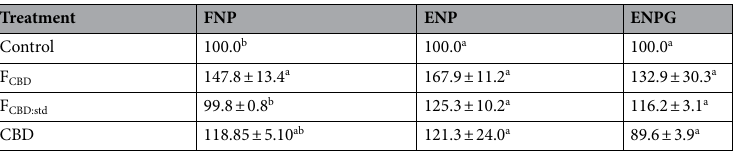
Table 3. Percentage of macrophage cells out of the control with internalized FNP silica beads, presence of ENP and ENPG silica beads analyzed using imaging flow cytometry, following treatment with F CBD at 7 µg/ mL, F CBD:std at 7 µg/mL, CBD at 4.35 µg/mL, or the control. Control (0.7% v/v methanol) treatment served as the solvent (vehicle) control. Fluorescein labeled silica particles (FNP: 50–100 nm, ENP: 30–70 nm, ENPG: 30-70 nm coated with IgG). At least 4000–6000 cells for each treatment were analyzed and the distribution of cell internalization scores were plotted using Amnis IDEAS software (n = 2). Means in the same column labelled with different letters are significantly different from all combinations of pairs according to the Tukey– Kramer HSD test ( P ≤